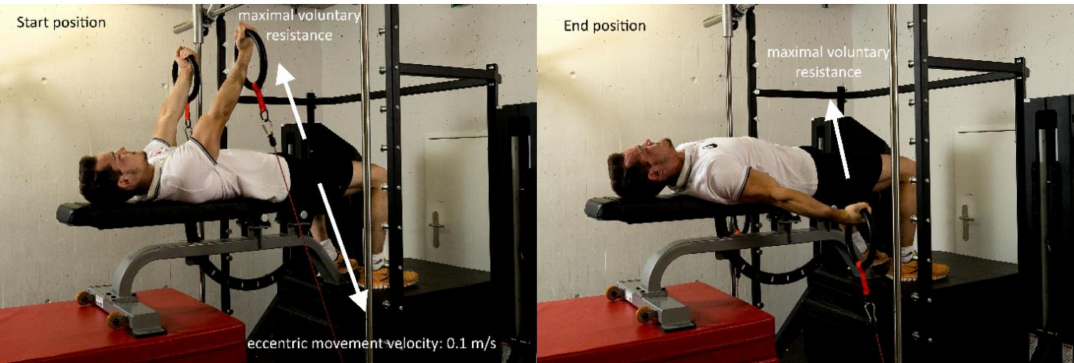
Figure 4. Training exercise. Start ( left ) and end positions ( right ) of the eccentric–isokinetic training exercise for the swallow and support scale elements performed on the 1080 Quantum Syncro (1080 Motion, Lidingö, Sweden). The movement velocity of 0.1 m / s yielded a mean eccentric duration of ~5 s per repetition.